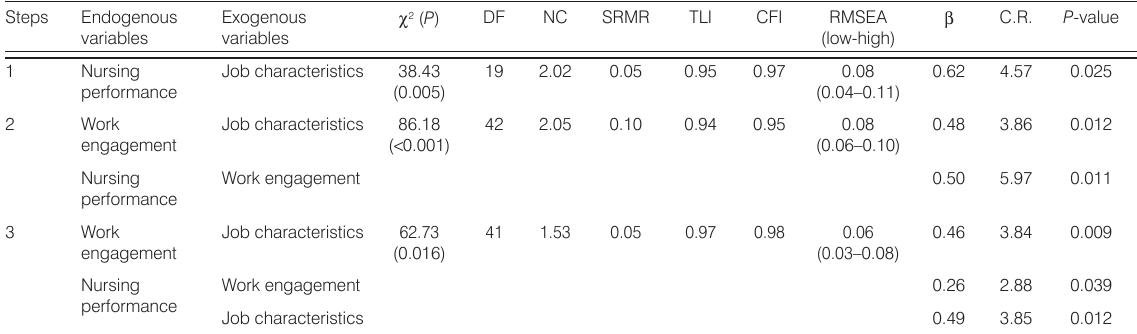
Table 3. Parameter estimates according to the testing steps of the structural models.